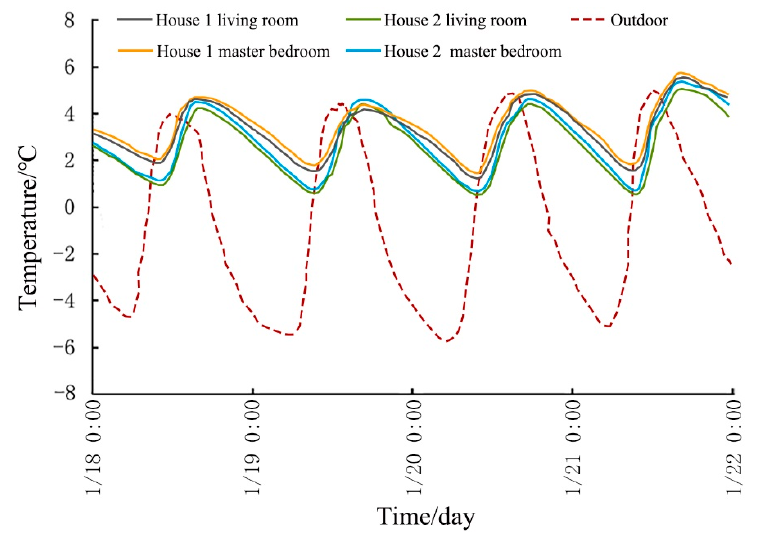
Figure 4. Outdoor and indoor temperature measurement of rural houses.